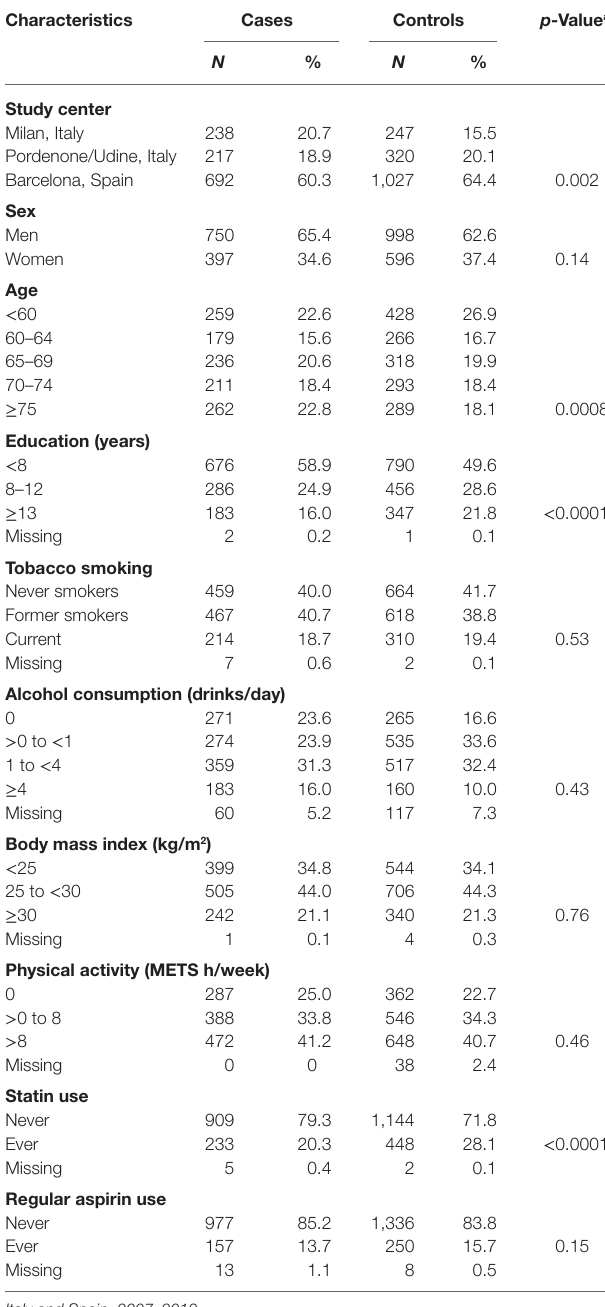
TaBle 1 | Distribution of 1,147 colorectal cancer cases and 1,594 controls, according to sex, age, and other selected characteristics. characteristics cases controls p -Value